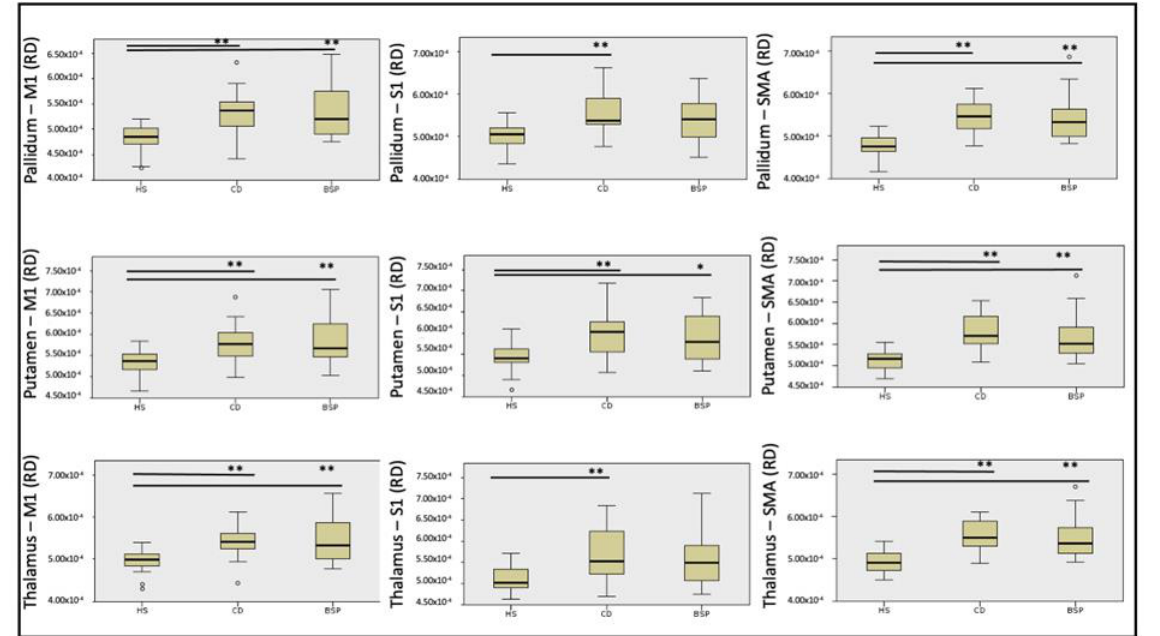
Figure 5. Differences in radial diffusivity (RD) of cortical-subcortical white matter tracts among subjects. HS: healthy subjects; CD: cervical dystonia; BSP: blepharospasm; M1: primary motor cortex head/face region; S1: primary sensory cortex head/upper limb region; SMA: supplementary motor area. Kruskal–Wallis post hoc analysis (* p < 0.05, ** p < 0.001). Circles indicates outliers.